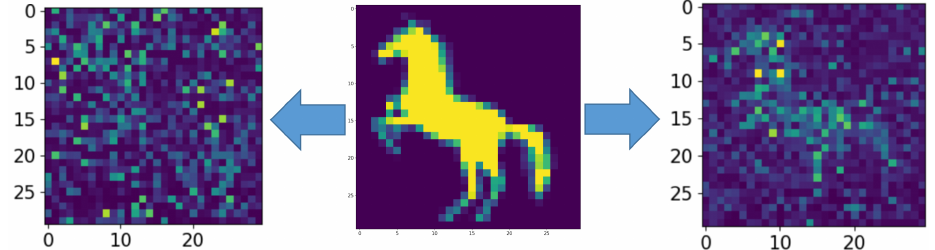
Figure 2. The middle picture is the supplied pattern (image of the horse), on the left, encoded by the spiking neural network without astrocyte modulation and noise amplitude A noise = 6, and on the right, with astrocyte modulation and noise amplitude A noise =